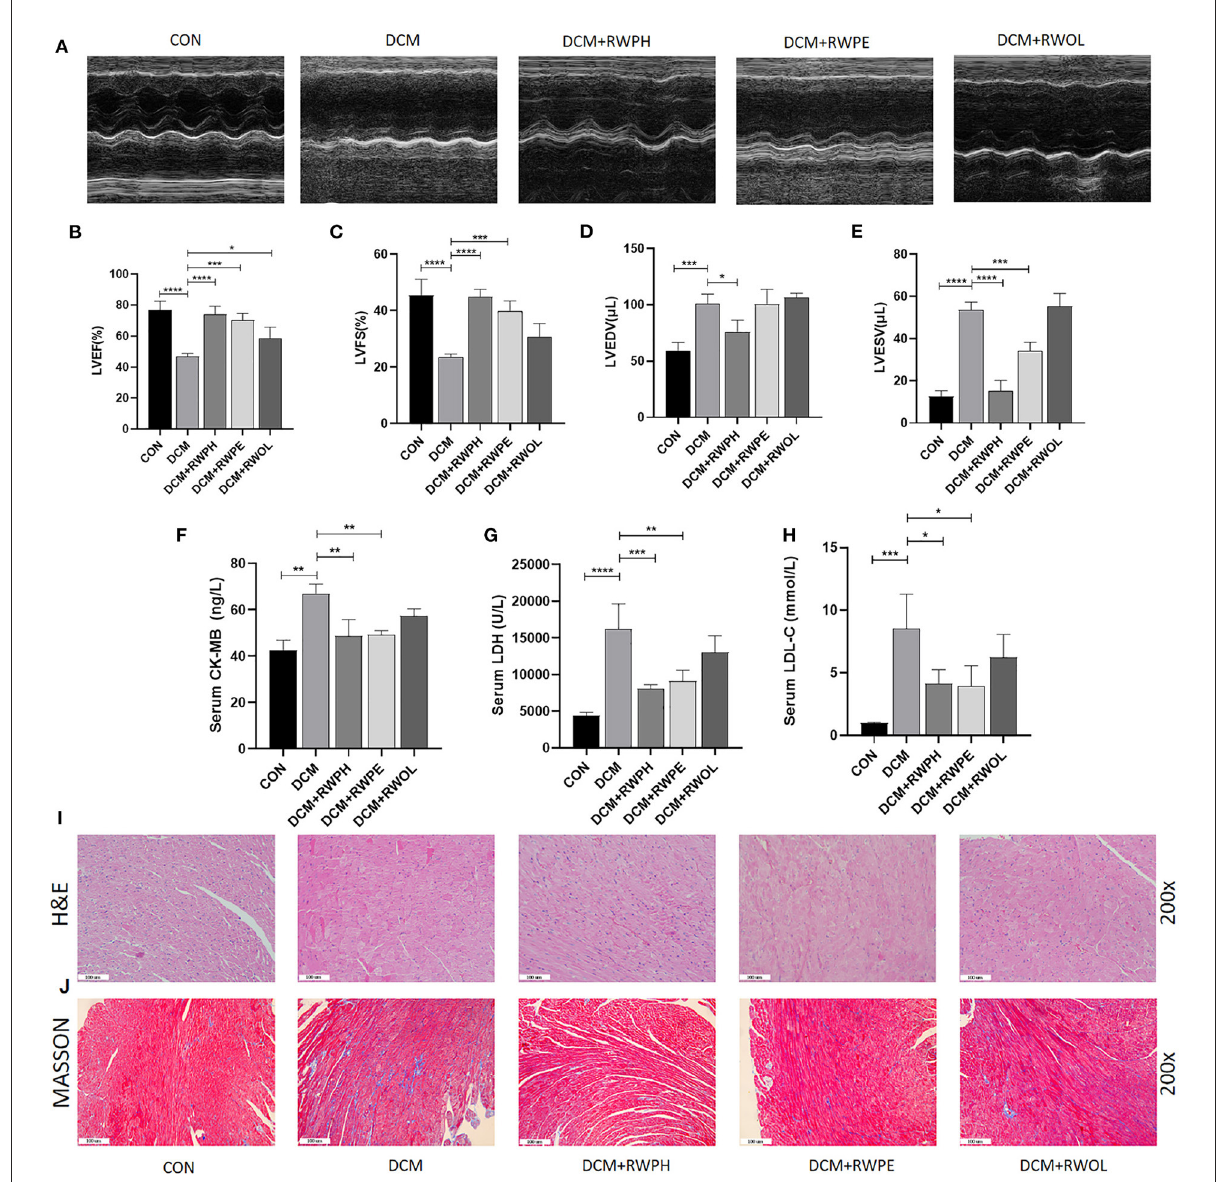
FIGURE1 RWPH and RWPE ameliorate cardiac function and alleviate cardiac fibrosis and cardiomyocyte hypertrophy in DCM mice. (A) M-mode echocardiography and corresponding images of each group mice hearts. (B–E) Results of (B) left ventricular ejection fraction (LVEF), (C) left ventricular fractional shortening (LVFS), (D) left ventricular end-diastolic volume (LVEDV) and (E) left ventricular end-systolic volume (LVESV) in each group mice. (F–H) , Results of (F) serum creatine kinase-MB (CK-MB), (G) serum lactate dehydrogenase (LDH) and (H) serum low-density lipoprotein cholesterol (LDL-C) in each group mice. (I) Hematoxylin and eosin (H&E) staining of the left ventricular tissue section in each group mice. (J) Masson trichrome stain of the left ventricular tissue section in each group mice. * P < 0.05, ** P < 0.01, *** P < 0.001, and **** P < 0.0001.